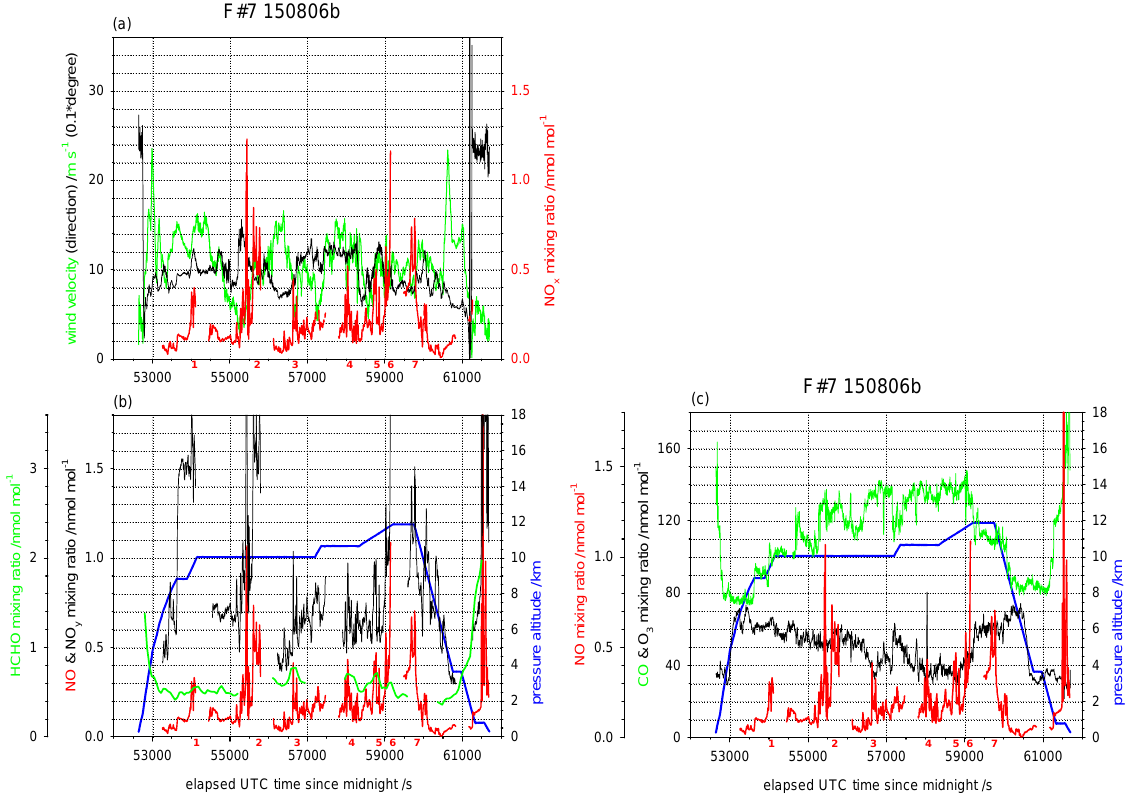
, HCHO, and pressure y